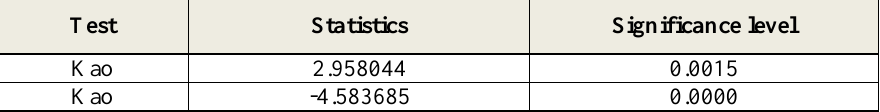
Table 11: Cointegration test using Kao